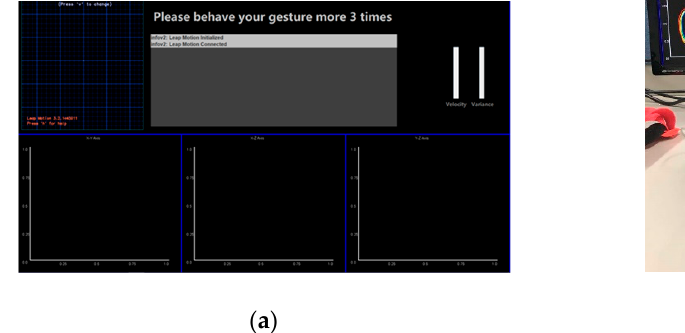
Figure 15. The gesture authentication system we developed for experiments. ( a ) Is the gesture interface. On the top are the real-time 3D gesture, console, bars of velocity, and variance from left to right. The X-Y, X-Z, and Y-Z gesture mappings are on the bottom. ( b ) Illustrates the use of the interface. To prove the performance of authentication and our approaches are work or not, the experiments